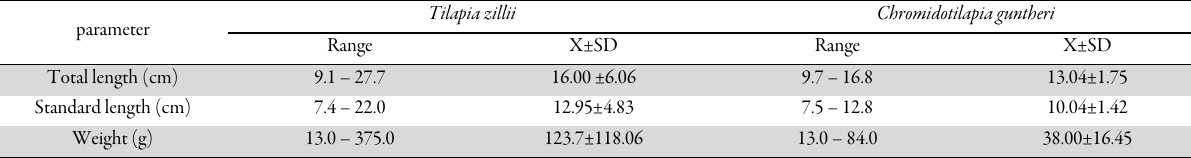
Table 2. Biometric parameters of Tilapia zillii and Chromidotilapia guntheri sampled from Igun gold mine reservoir